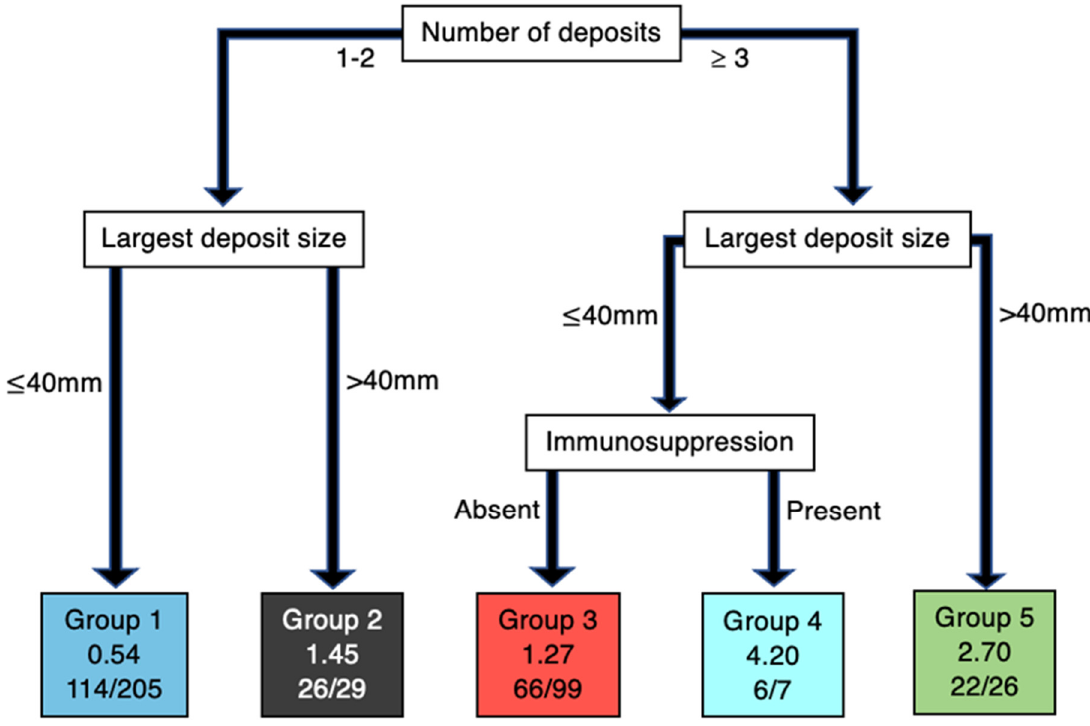
Figure 2. OS analysis. RPA decision tree. Groups 1–5 represented in leaves with Cox hazard ratio and OS ratio (number of events observed in group/overall group number).